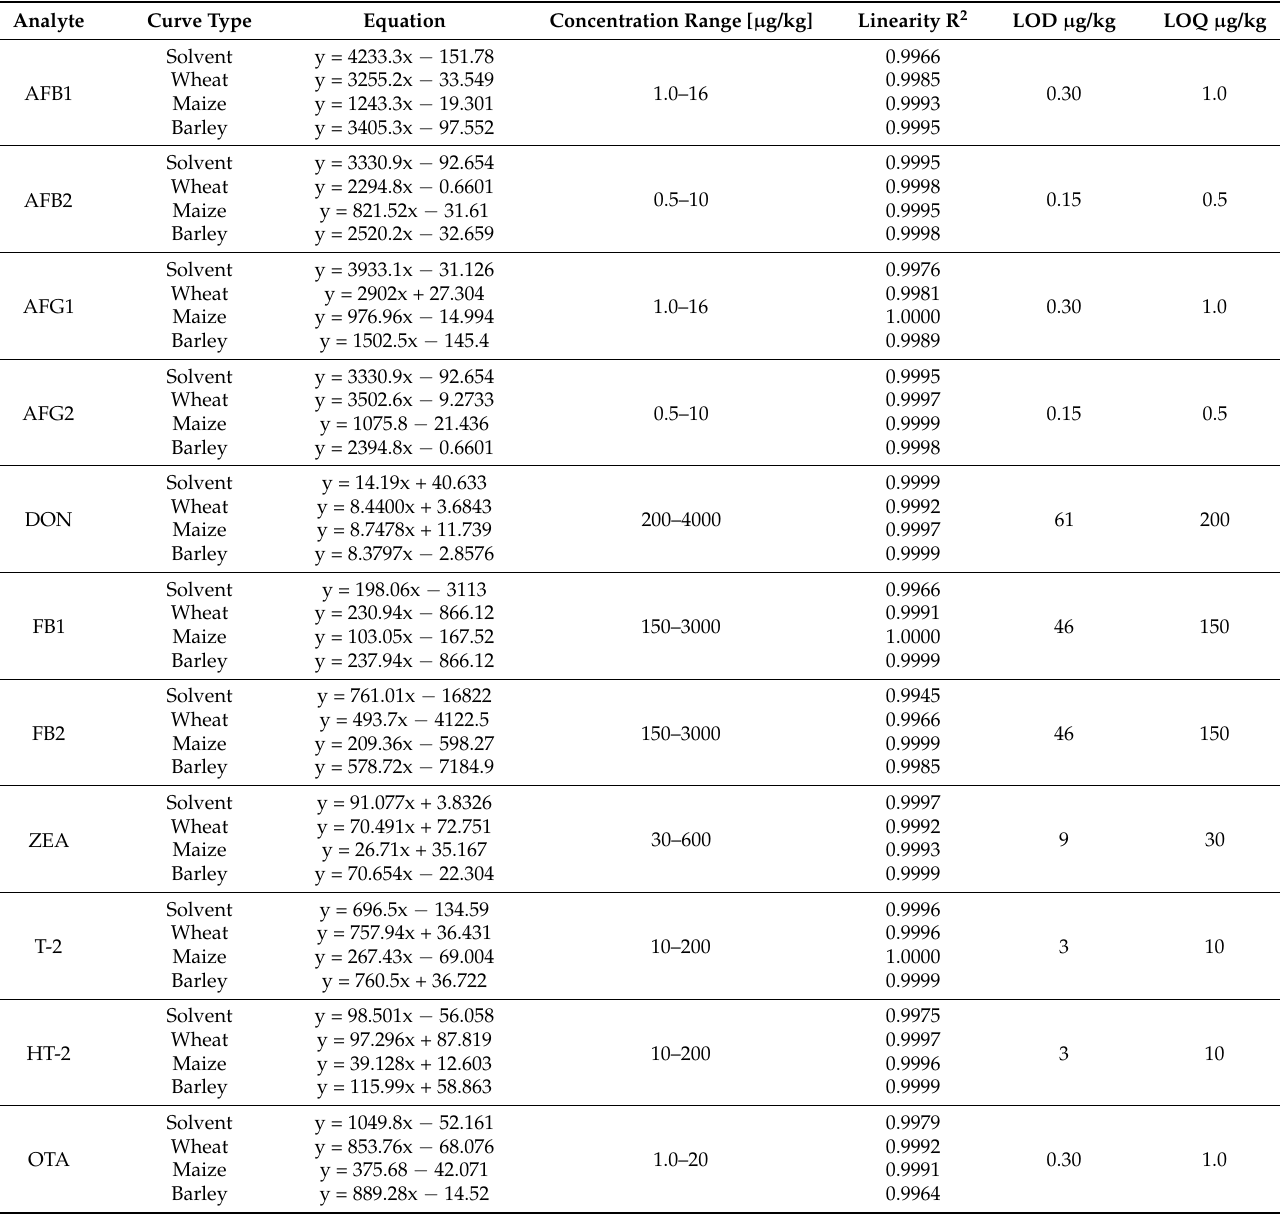
Table 6. Method performance characteristics in neat solvent and cereal